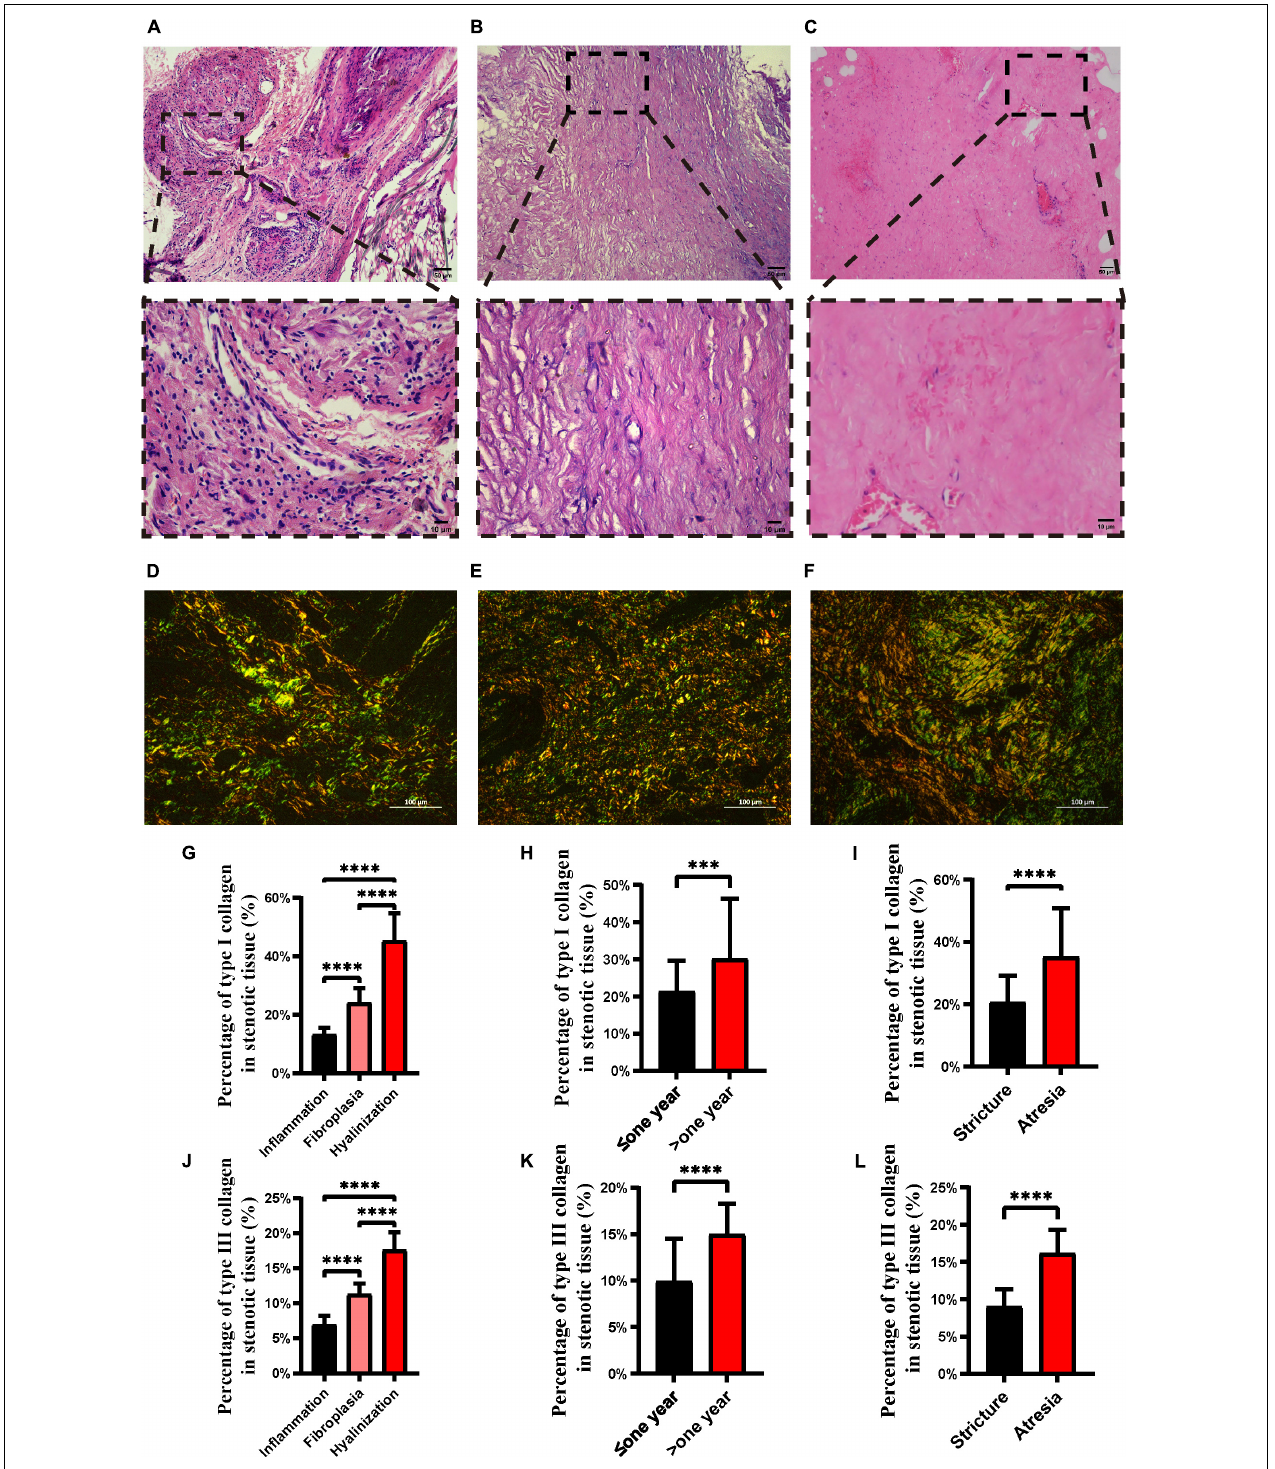
FIGURE 1 | H&E staining and picrosirius red staining of different ureteral stricture histopathology types. H&E staining of inflammation (A) , fibroplasia (B) and hyalinization (C) . Upper panel scale bar = 50 µ m; lower panel scale bar = 10 µ m. Picrosirius red staining of inflammation (D) , fibrous hyperplasia (E) and hyalinization (F) , where type I collagen is stained red or orange and type III collagen is stained green. Proportion of type I (G) and type III (J) collagen in the three pathological types of ureteral strictures. Proportion of type I (H) and type III (K) collagen in the different pathological courses. Proportion of type I (I) and type III (L) collagen in strictures and atresia. Scale bars, 100 µ m ( ∗∗∗ p < 0.001; ∗∗∗∗ p < 0.0001).